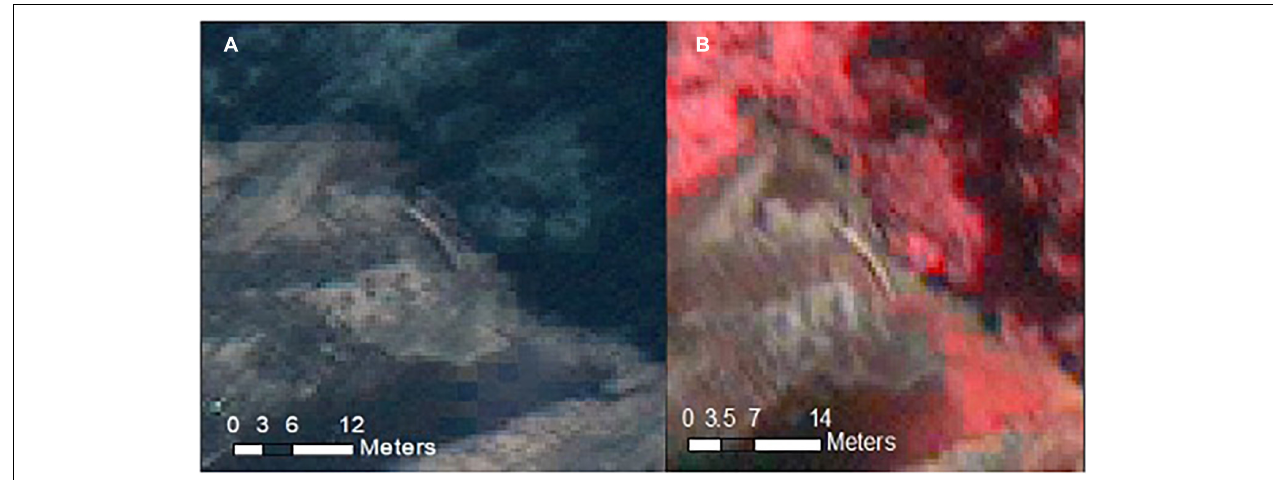
FIGURE 4 | (A) An image of a possible whale-like feature identified in the 2019 VHR satellite imagery, displaying a similar appearance to the confounding wood features in Figure 3C . (B) An image of the same possible whale-like feature displayed in 4 (A) , however, the image is displayed in the red and NIR bands and demonstrates the contrast between the high spectral reflectance (pink/cream hue) of the possible whale like feature when compared with the red colour of the surrounding vegetation. All images are courtesy of Digital Globe Foundation (now Maxar